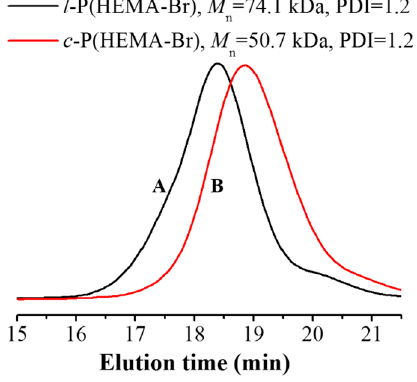
Figure 2. 1 HNMR spectra of c -PHEMA ( A ) and c -P(HEMA–Br) ( B ) in DMSO- d 6 .